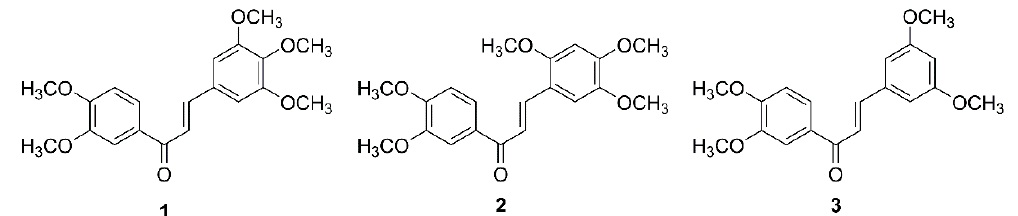
Figure 1. Chemical structure of chalcones 1–3 .